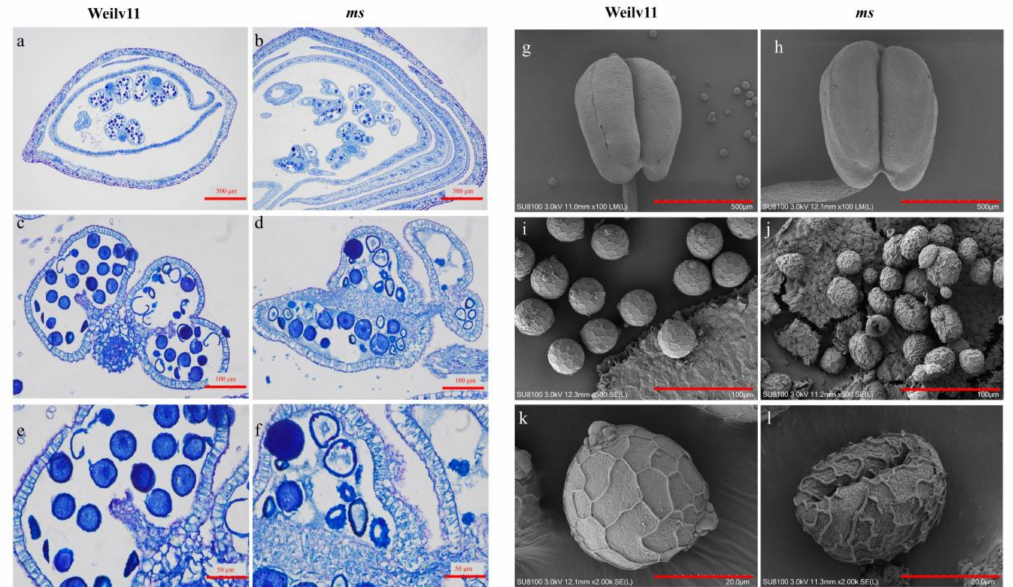
Figure 2. Histocytological and microscopic analyses of pollen in Weilyu 11 and ms. Longitudinal sections of other wild-type lines (background Weilyu 11 ( a , c , e ) and mutant ( ms , ( b , d , f )) in mature flowers under a high-resolution white camera, where the bars represent 500, 100 and 50 µ m, respec- tively. Microscopic analyses of wild-type lines (background Weilyu 11 ( g , i , k )) and mutant ( ms , ( h , j , l )) in mature flowers, where the bars represent 500, 100 and 20 µ m, respectively. Both ( c , e ) and ( d , f ) are enlarged images of ( a , b ); ( k , i ) sections of the images in ( g , h ), respectively. ( a – f ) Glowers sampled at 0